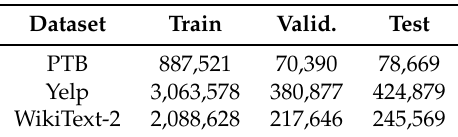
Table 1. Statistical information of datasets used in our experiments. Number stands for the total token size in training, validation and testing of three